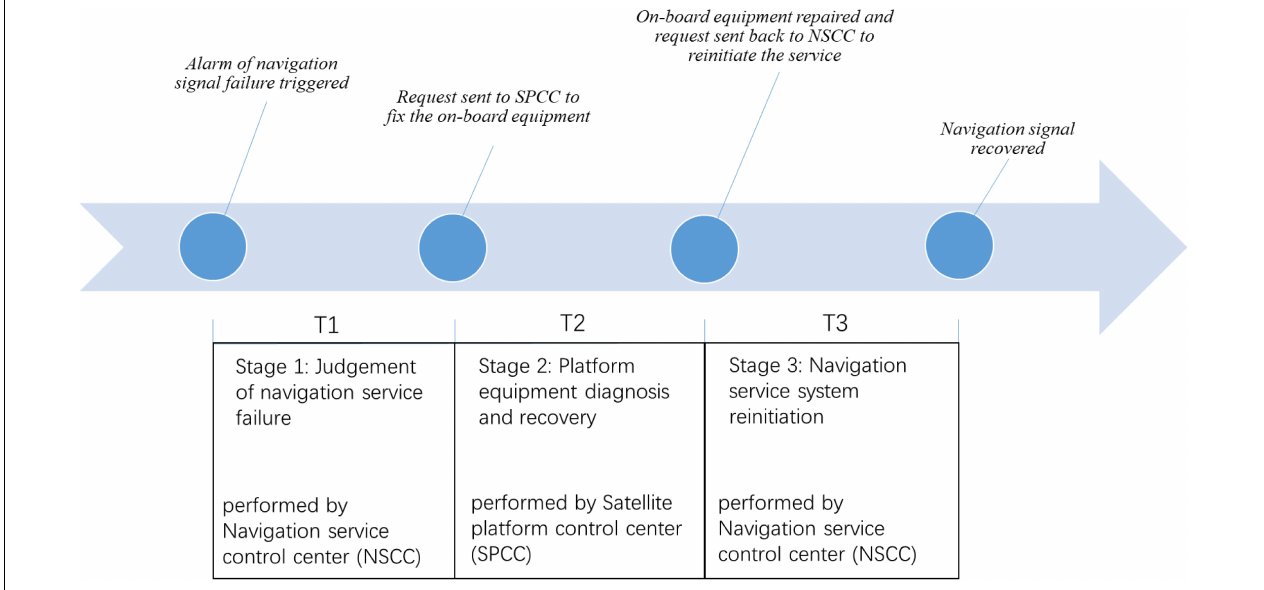
operator performance when the baseline tasks are too